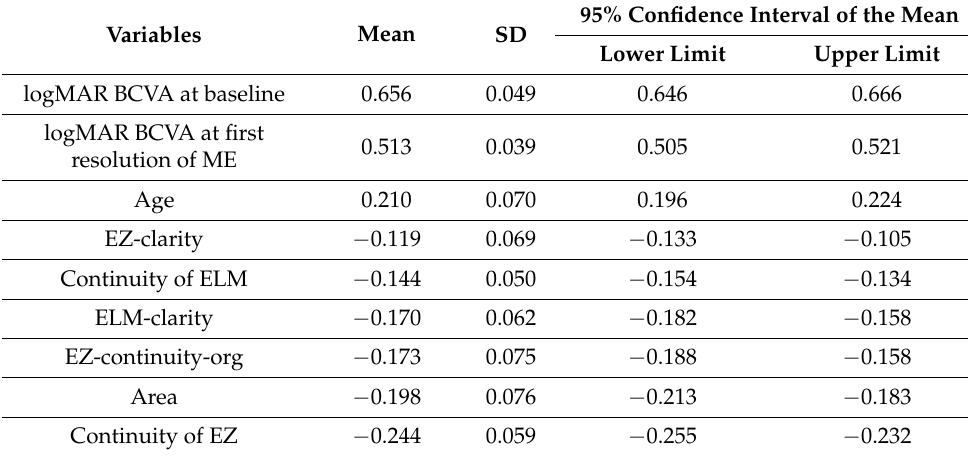
Table 4. Coefficients of explanatory variables.